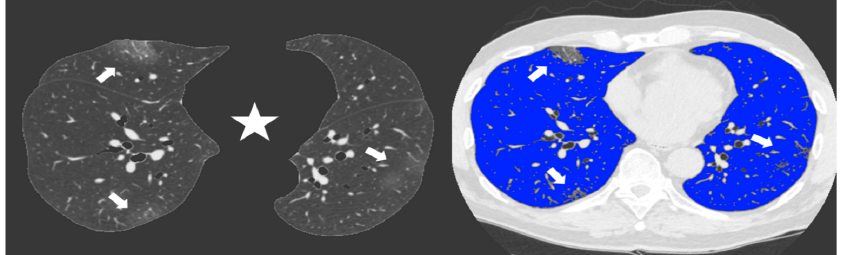
Figure 3. Non-enhanced axial Chest CT software reconstructions showing peripheral sub-pleural isolated GGOs (arrows). On the left the axial image automatically segmented by the software ex- cluding all “non-lung” structures (mediastinum, upper airways and spine) (star) for visual quanti- fication of infected parenchyma. On the right the same image highlighting in blue the well aerated lung and the COVID19 infection signs in grey. The whole infected volume assessed by software was 7% of the entire lung volume. The patient had good clinical course without need for invasive venti- lation.